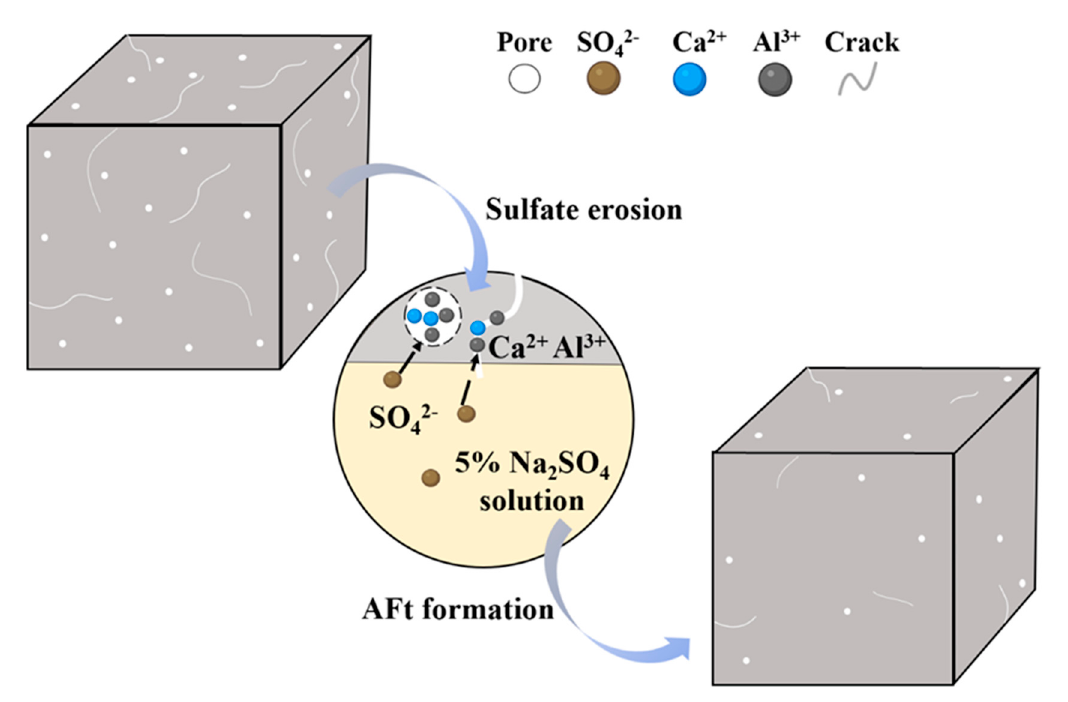
Figure 12. Mechanism diagram of FRC resistance to sulfate erosion.